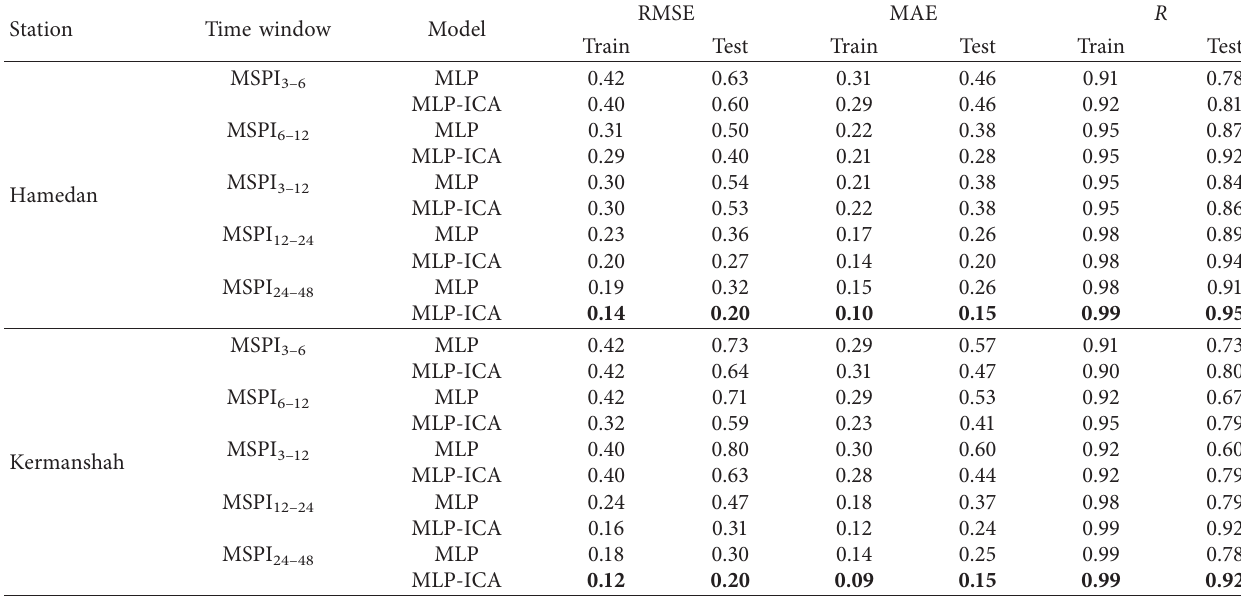
Table 4: Evaluating the predictions of the models MLP and